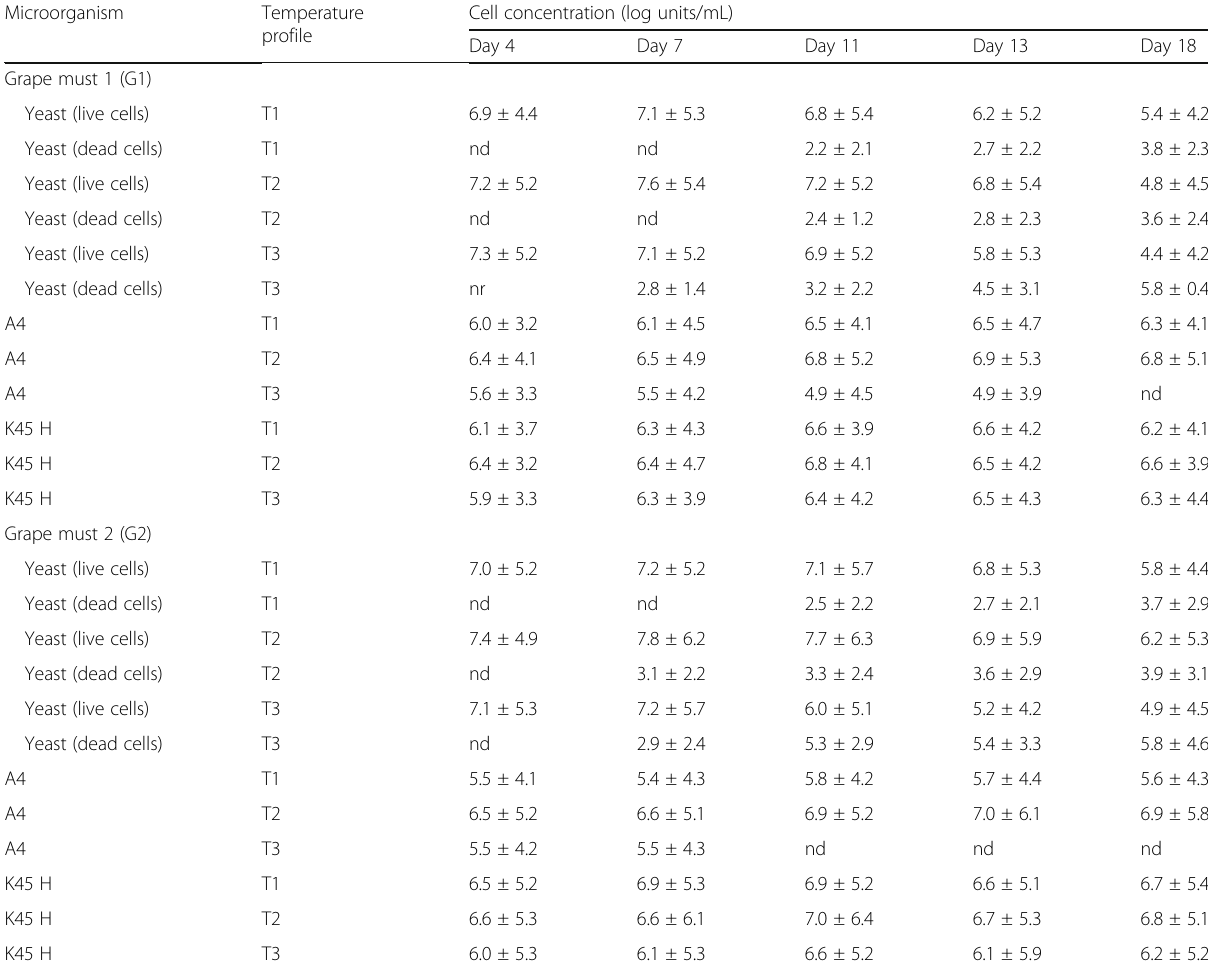
Table 1 Result of yeast (flow cytometric determination) and bacteria count (plate count onto MRS + TJ) performed during the 3 experimental winemaking. T1 test: 16/22 °C in 3 days, B. T2 test: 18/24 °C in 3 days, and C. T3 test: 22/32 °C in 5 days. (Mean, n = 6 in the case of yeast and n = 3 in the case of LAB)